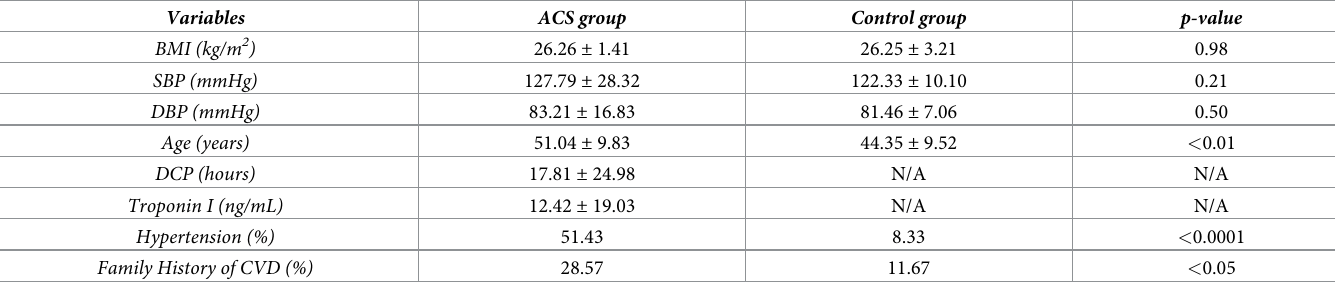
Table 1. Baseline features of the ACS cases and the